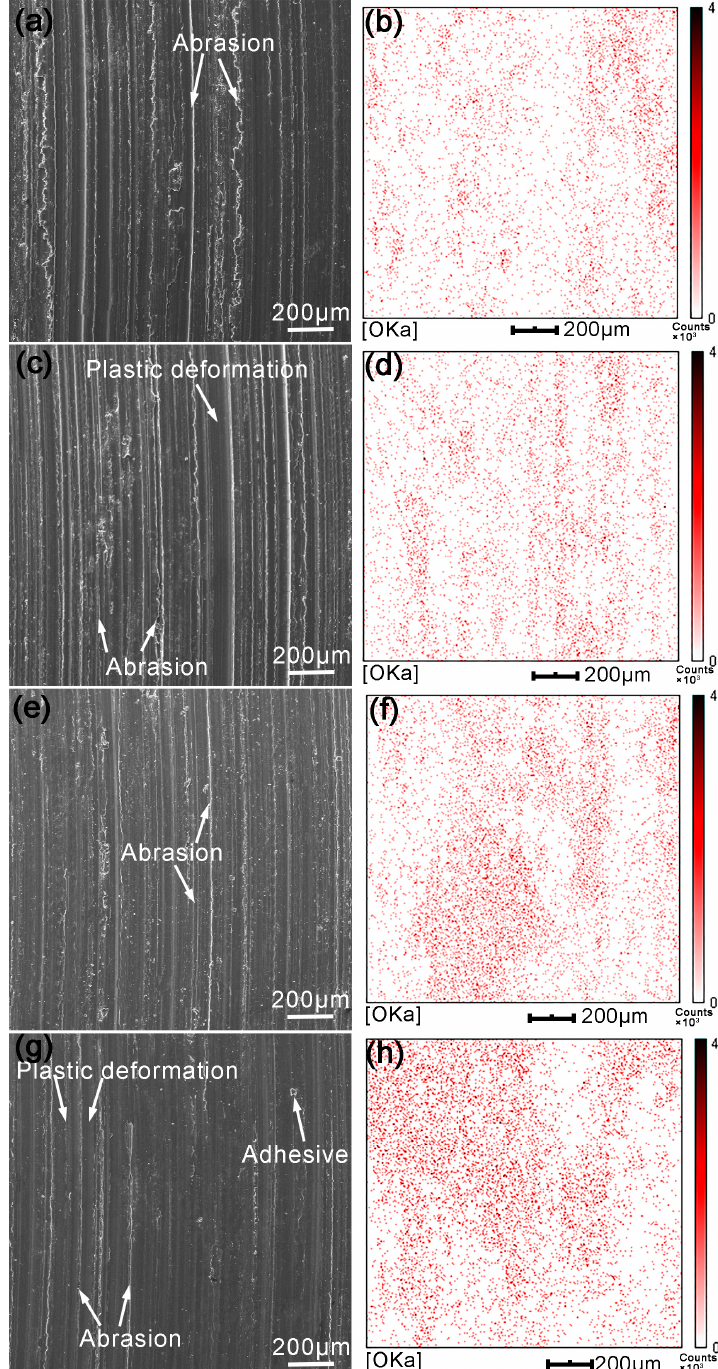
Figure 10. SEM micrograph and the results of EDS plane scan of the worn surface of surfacing alloys with 1.5% Ce after sliding under a sliding load of 10 N and different speeds: ( a ) 0.25 m/s; ( b ) EDS analysis of ( a ); ( c ) 0.5 m/s; ( d ) EDS analysis of ( c ); ( e ) 1.0 m/s; ( f ) EDS analysis of ( e ); ( g ) 1.25 m/s; ( h ) EDS analysis of ( g ).